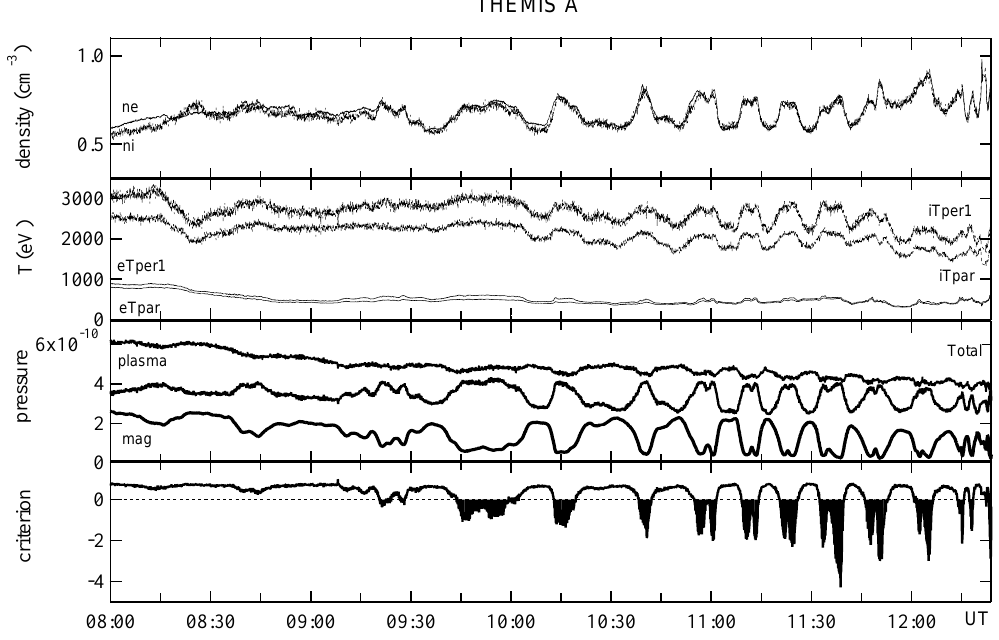
Fig. 4. Plasma parameters for THEMIS-A from 08:00UT to 12:24UT on 7 November 2007. From top to bottom, the panels show (a) the ion and electron densities, (b) the ion and electron temperatures perpendicular and parallel to the magnetic field, (c) the magnetic pressure ( B 2 /2 µ 0 ) , the sum of the ion and electron ( n i kT i ⊥ + n e kT e ⊥ ) thermal pressures perpendicular to the magnetic field, and sum of the plasma and magnetic pressures, and (d) results from test of the mirror instability criterion. Shaded grey areas indicate the times where the drift mirror instability is satisfied ( <